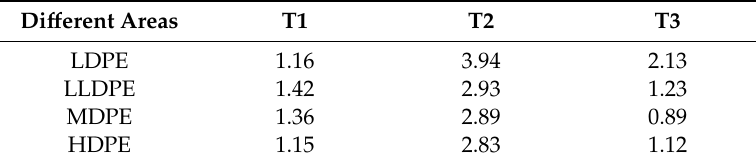
Figure 6. Conduction current characteristic curve of polyethylene with different densities: ( a ) LDPE I-E; ( b ) LLDPE I-E; ( c ) MDPE I-E; ( d ) HDPE I-E. Table 3. The slope of the line in di ff erent areas of di ff erent